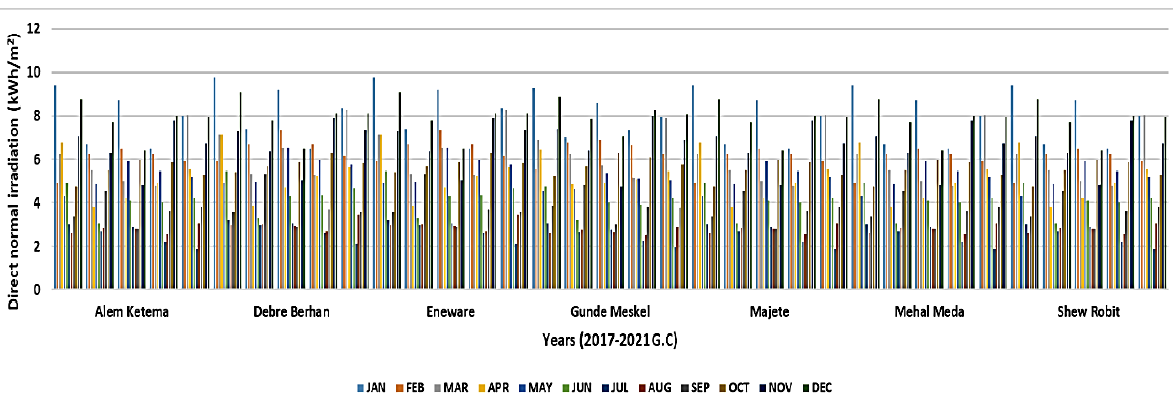
Figure 5. NASA ’ s assessment of solar radiation [35].